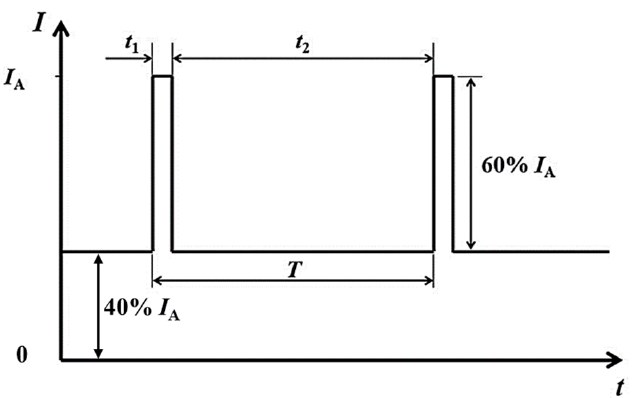
Figure 3. Schematic diagram of the applied ideal pulse current waveform.